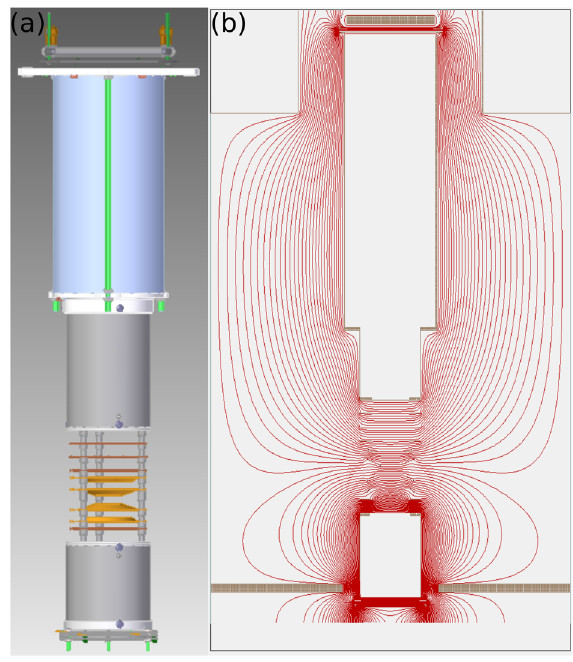
Figure 8. ( a ) 3D CAD rendering of the double-sided electron-ion momentum imaging spectrometer. ( b ) SIMION-simulated equipotential lines of the electric field used in the